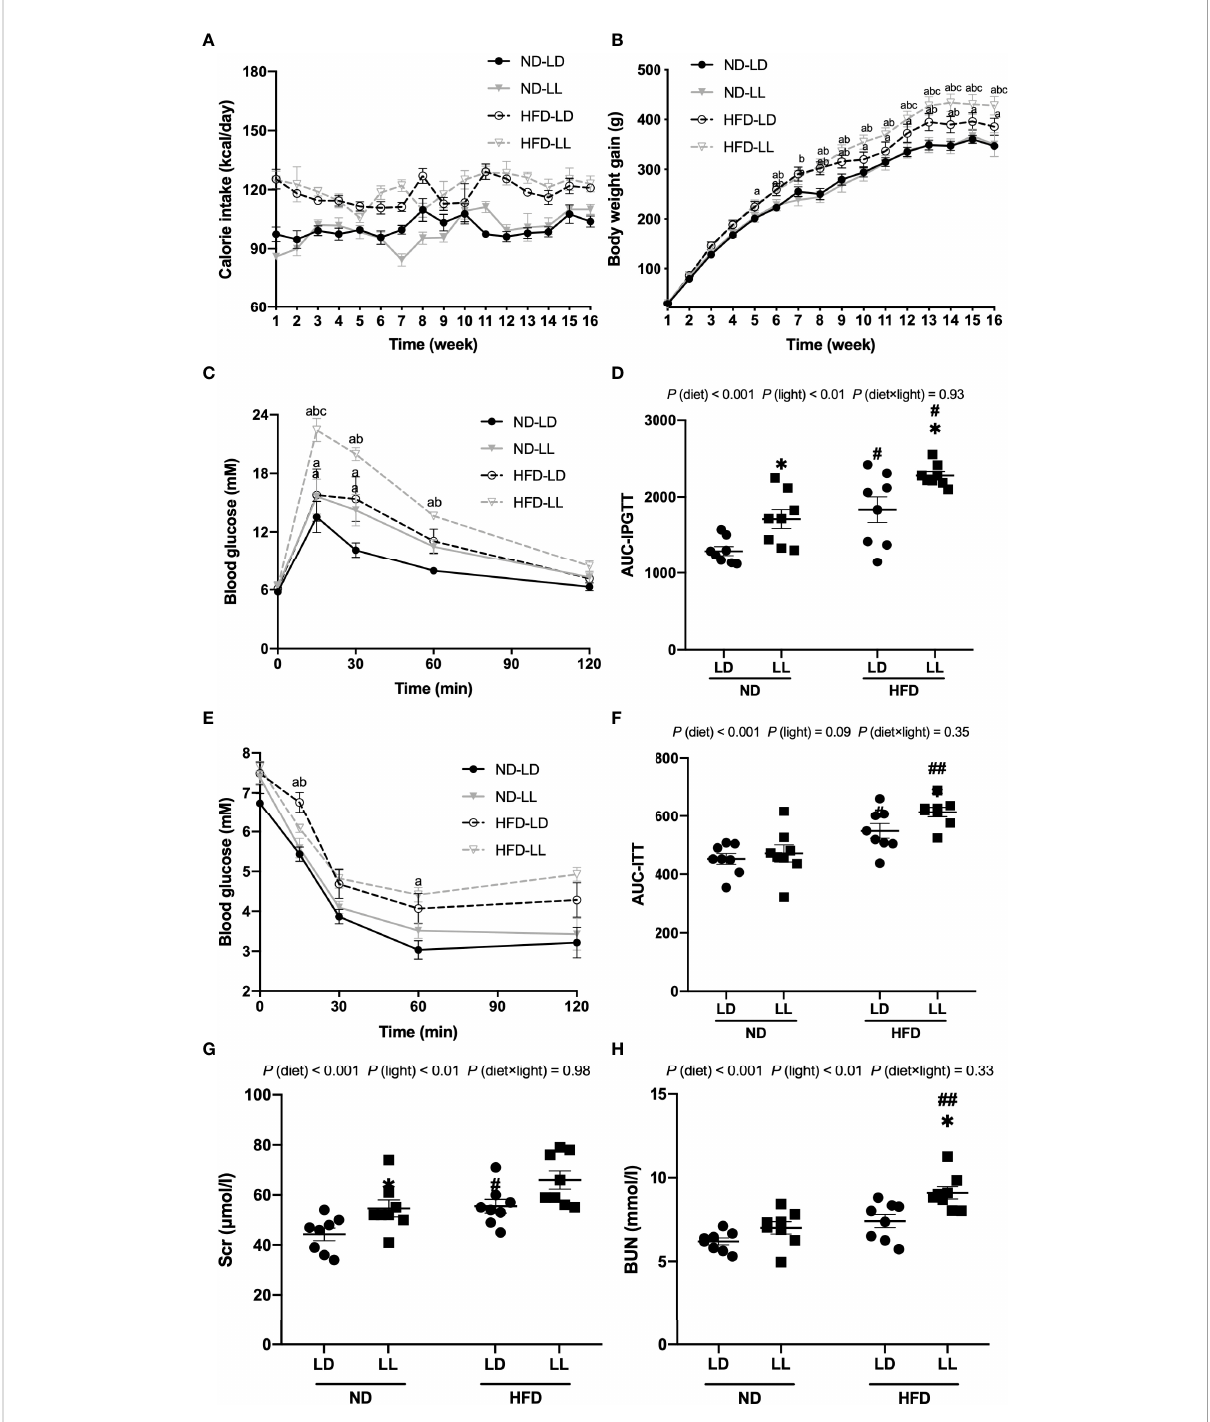
FIGURE 1 Effects of constant light on calorie intake, body weight gains, intraperitoneal glucose tolerance test (IPGTT), insulin tolerance test (ITT) and renal function in rats. (A) Changes of calorie intake. (B) Changes of body weight gain. (C) IPGTT. (D) Area under the curve (AUC) of IPGTT. (E) ITT. (F) AUC of ITT. (G, H) Serum creatinine (Scr) and blood urea nitrogen (BUN) at the end of the experiment. Values represent mean ± SEM (n=8). Differences were determined using either a one-way ANOVA (A – C, E) or a two-way ANOVA followed by a Bonferroni post hoc analysis (D, F – H) . a p <0.05 vs. ND-LD group, b p p<0.05, vs. ND-LL group, c p p<0.05, vs. HFD-LD group. # p <0.05, ## p <0.01, vs. ND counterpart. * p <0.05, vs. LD counterpart. p (diet), main effect of diet; p (light), main effect of light; p (light × diet), interaction effect of light and